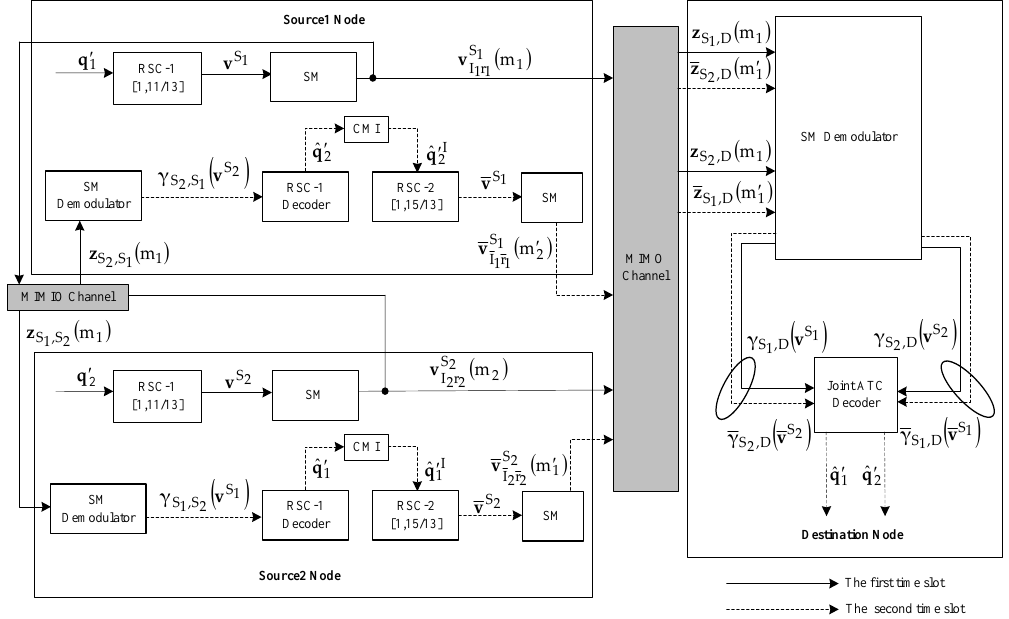
Figure 6. Two-source asymmetric turbo-coded cooperative ( ATCC)-SM scheme with the CMI.